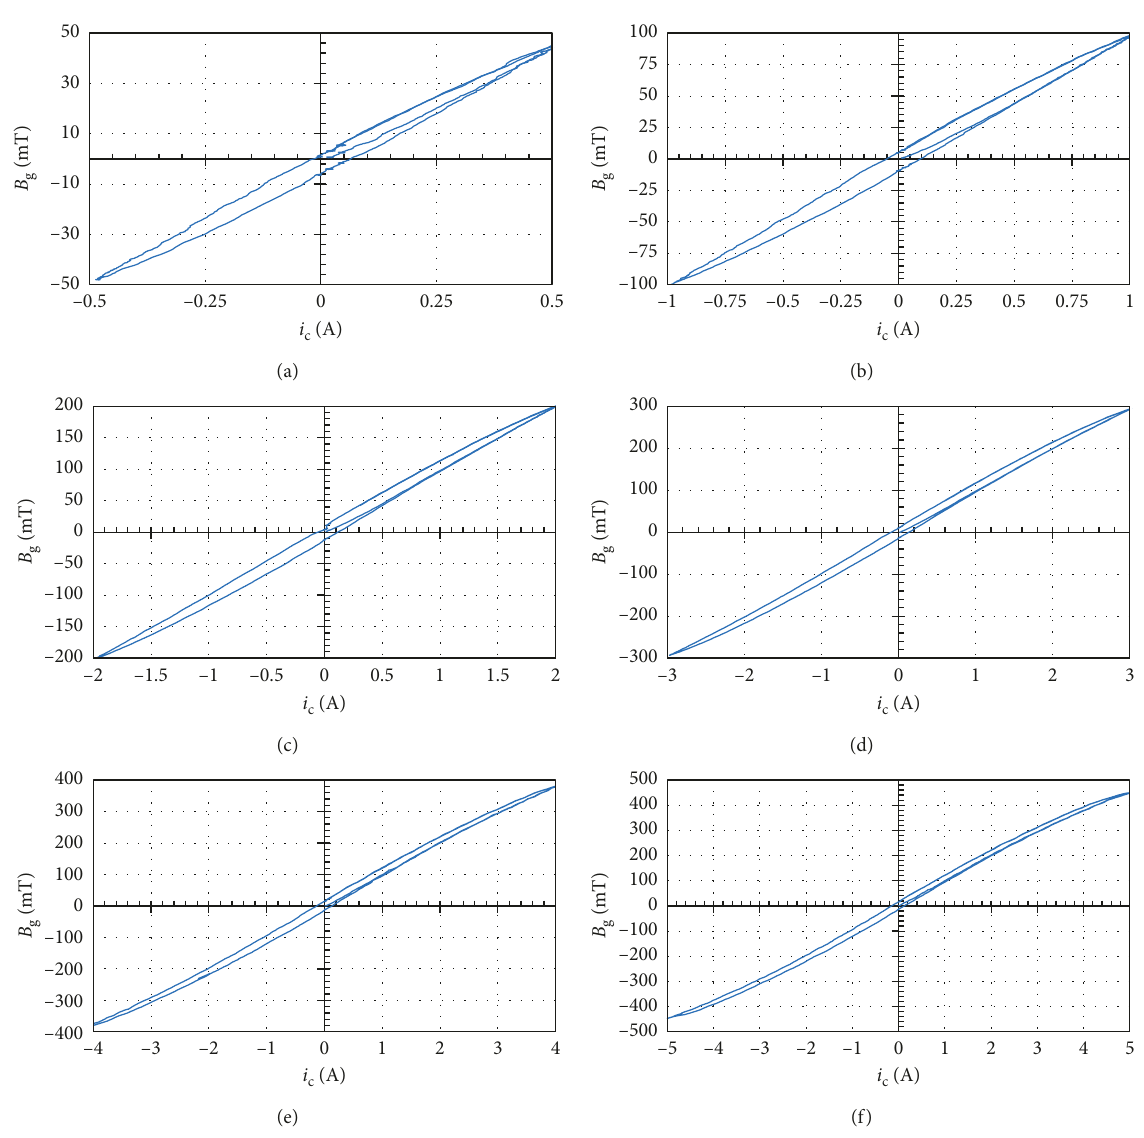
Figure 11: Flux density measurements: air gap, no MR fluid. (a) I (e) I max � 4.0 A. (f) I max � 5.0A.